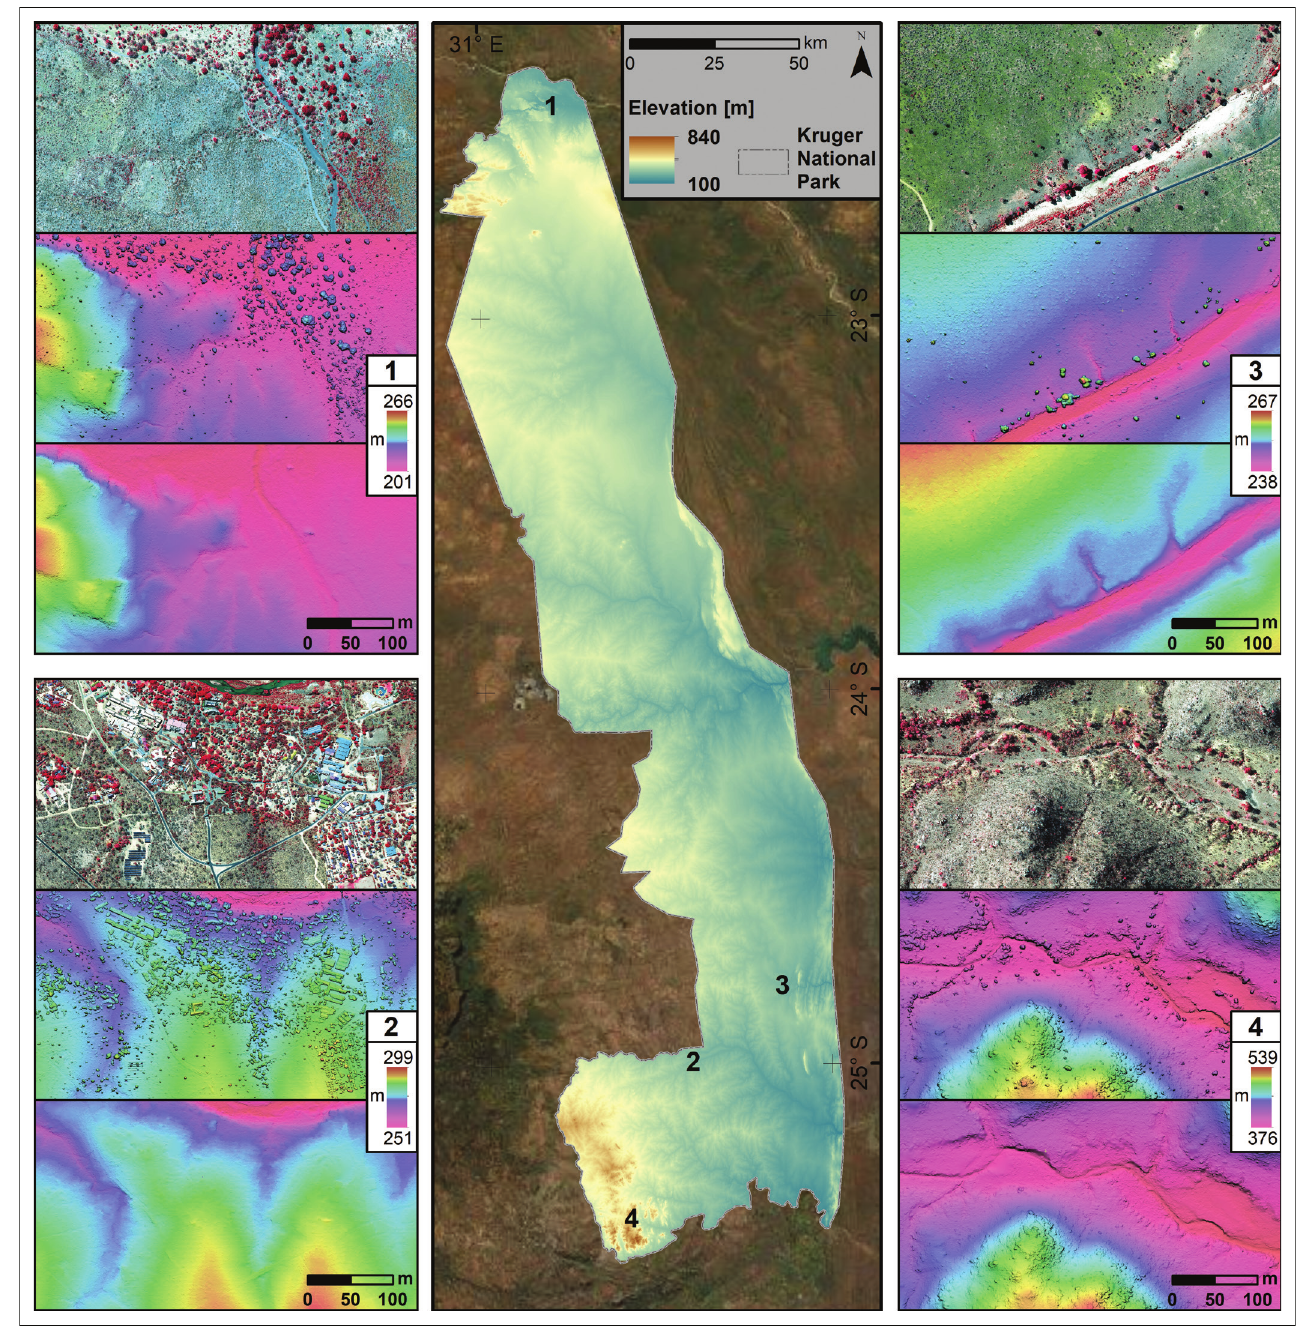
FIGURE 5: Orthomosaic (upper), digital surface model (middle) and digital terrain model (lower) generated from aerial imagery for four different sites across the Kruger National Park at a scale of